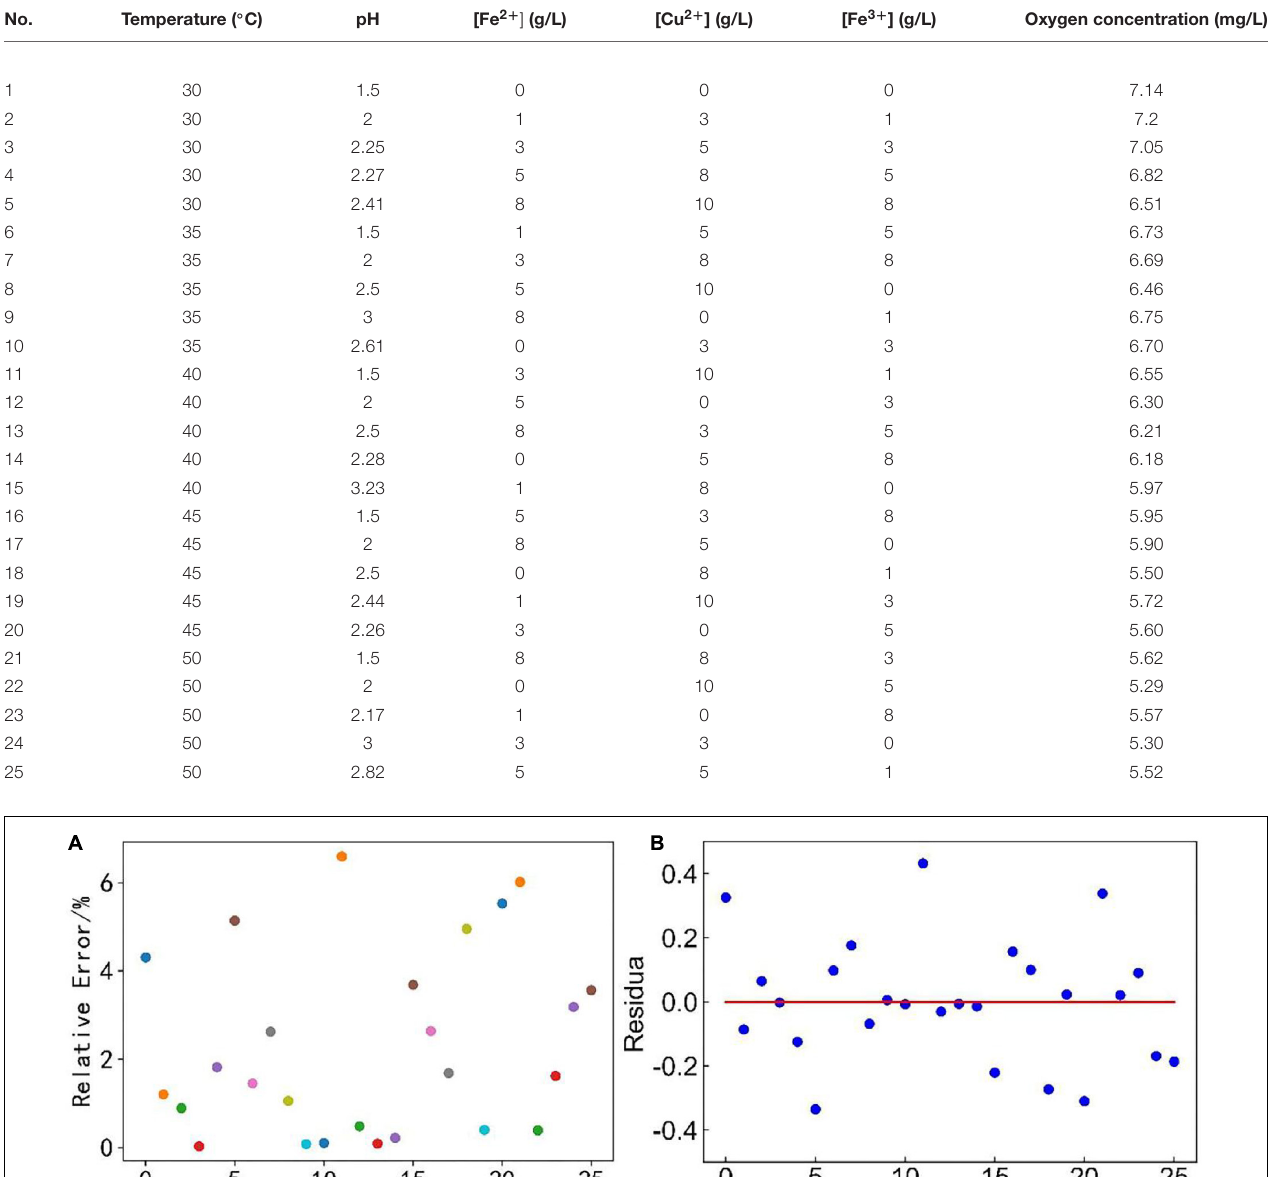
TABLE 2 | Saturated dissolved oxygen concentration measurements.